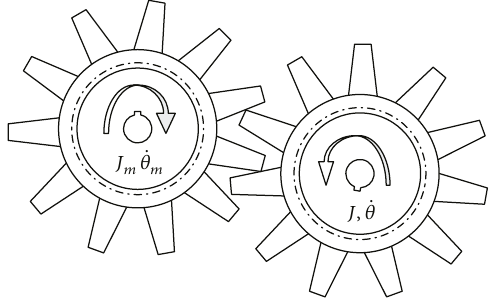
Figure 1: The hysteresis servo motor system structure. Table 1: The Bouc-Wen model